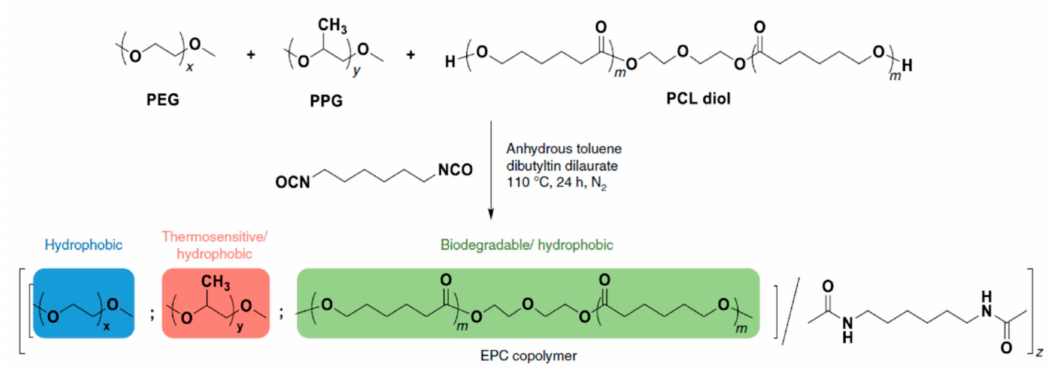
Figure 2. Schematic representation of the polymerization procedure for synthesis of a biocompatible and biodegradable EPC copolymer